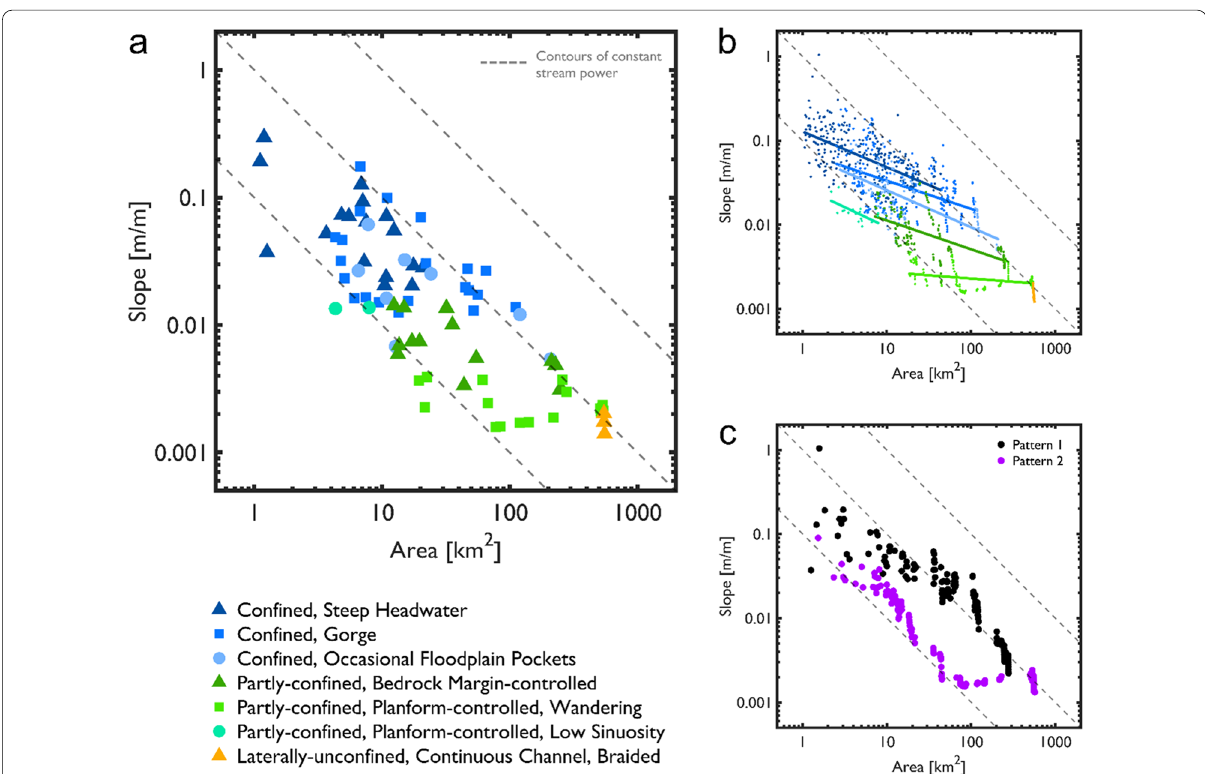
Fig. 6 Slope-catchment area relationships grouped by River Style: a values extracted at 2.5 km intervals along the stream network ( n averaged over 0.2 km segment lengths ( n 1129), coloured solid lines are log–log regressions; and, c comparisons between downstream Pattern 1 = and Pattern 2. Dashed lines are contours of constant stream power ( S α Q − 1 , see text for